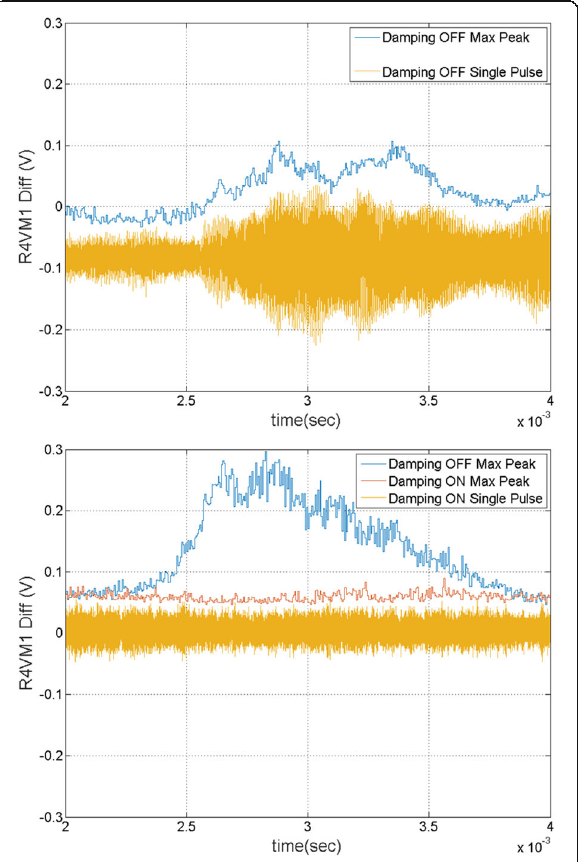
Fig. 20 Experimental results at the ISIS RCS; vertical beam oscillations [BPM differential signals (yellow)] measured without (upper) and with (lower) the damper [42]